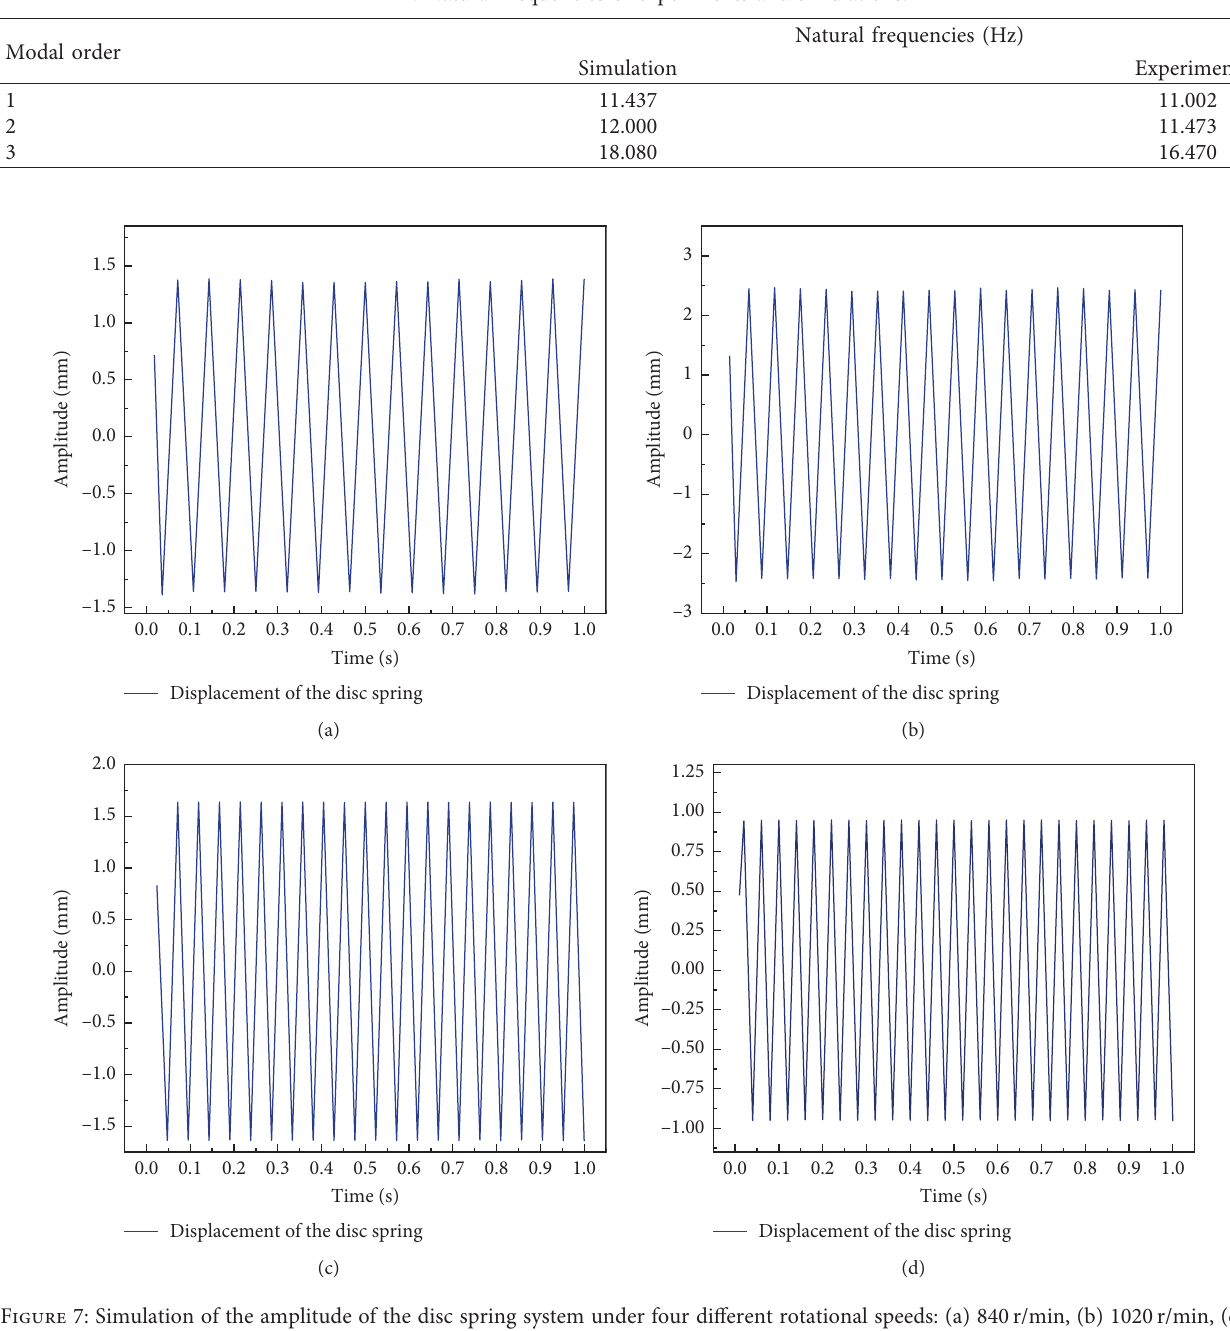
Figure 7: Simulation of the amplitude of the disc spring system under four different rotational speeds: (a) 840r/min, (b) 1020r/min, (c) 1260r/min, and (d)